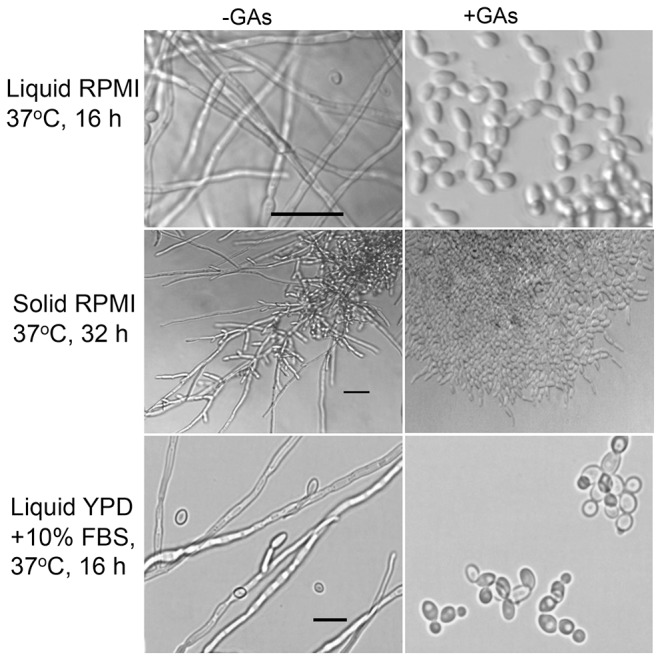
Gymnemic acids inhibit hyphal formation and extension by C. albicans.Effect of the addition of a mixture of GAs (GAs, 40 µg/ml) on the yeast-to-hypha conversion and filamentation induced by liquid, solid RPMI or in liquid YPD in the presence of 10% fetal bovine serum at 37°C in microtiter wells. Scale bars = 25 µm.